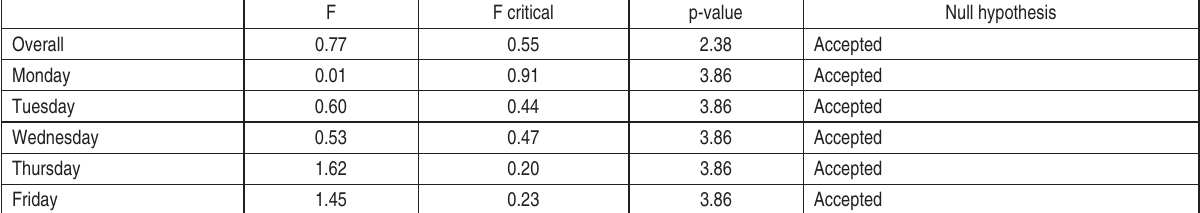
Table B6. ANOVA test of the day-of-the-week effect for UX futures